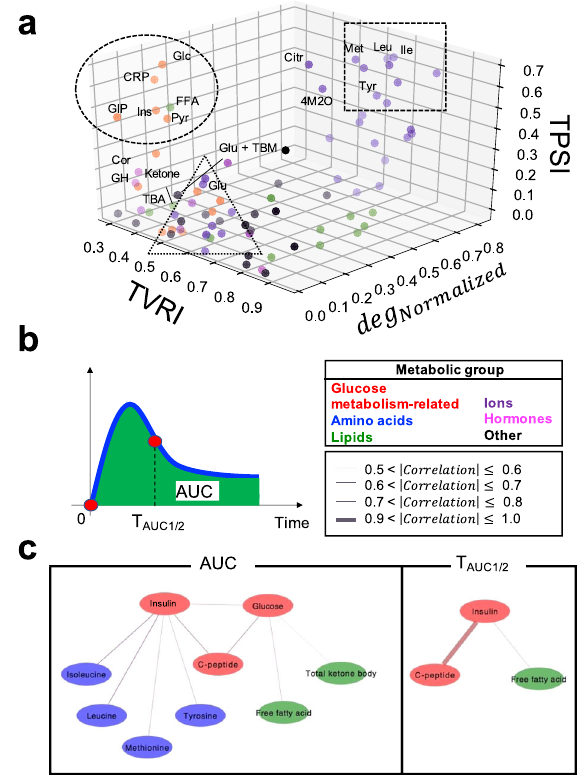
glucose-responsive molecules that showed a signi fi cant change after glucose ingestion (Supplementary Fig. 3) are labelled and